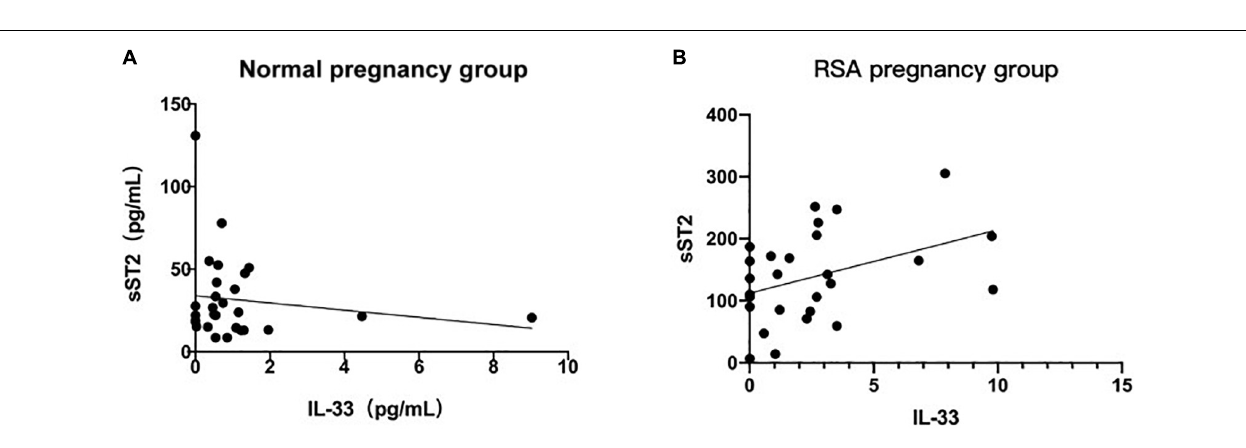
FIGURE 5 | Correlation of maternal serum IL-33 and ST2 level. (A) Correlation analysis between serum IL-33 and ST2 level in the normal pregnancy group. (B) Correlation between serum IL-33 and ST2 level in the RSA pregnancy group. (Values corresponding to the same number of weeks of gestation are plotted using their mean